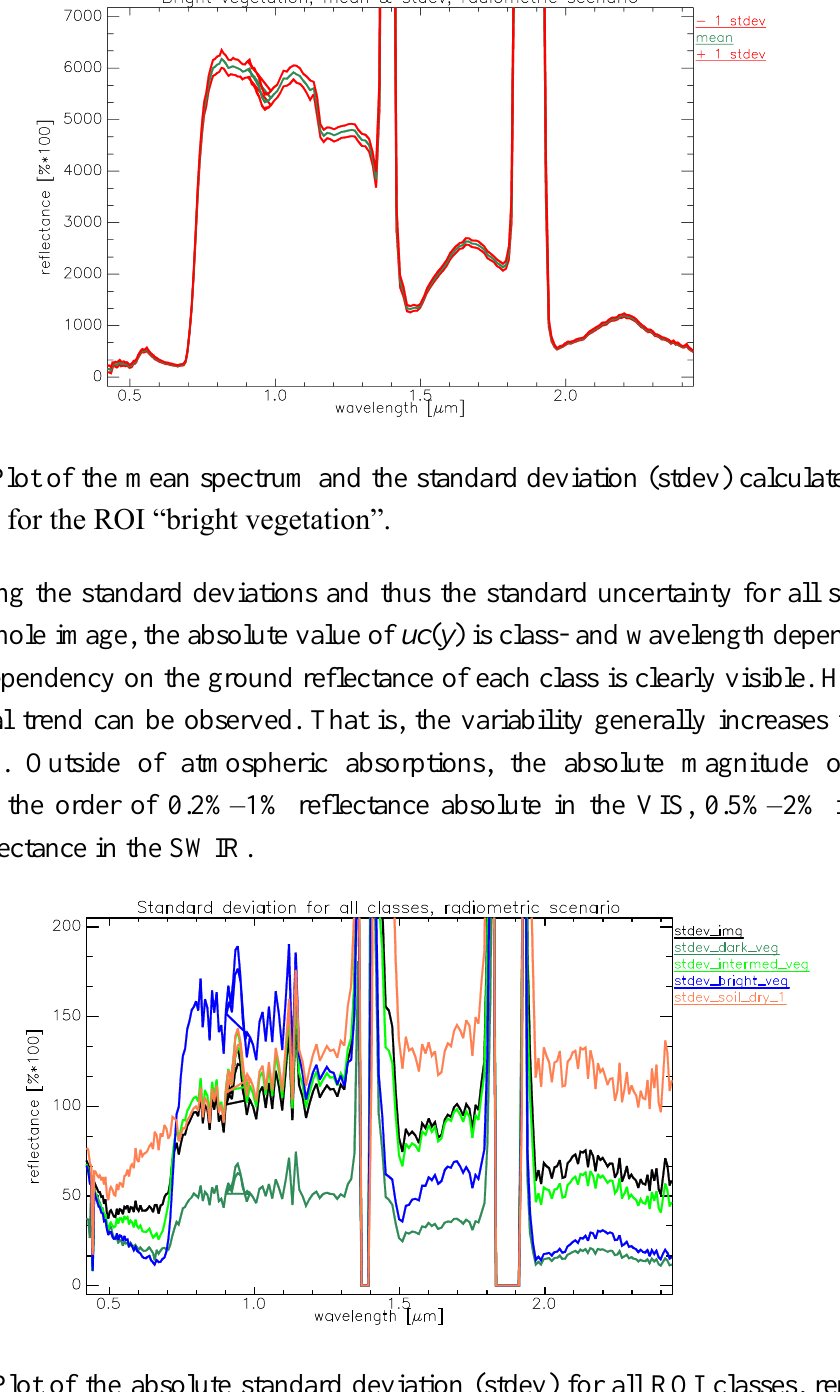
Figure 6. Plot of the absolute standard deviation (stdev) for all ROI classes, representing the combined standard